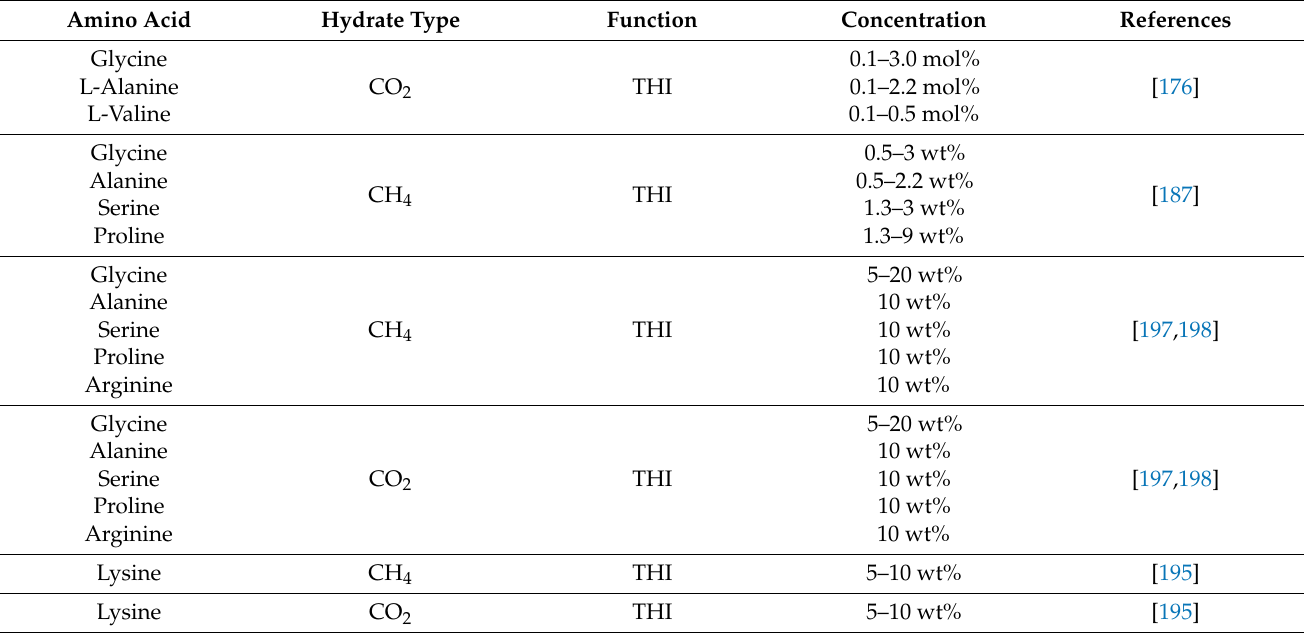
Table 11. Summary of amino acids used as thermodynamic hydrate inhibitors relying on several